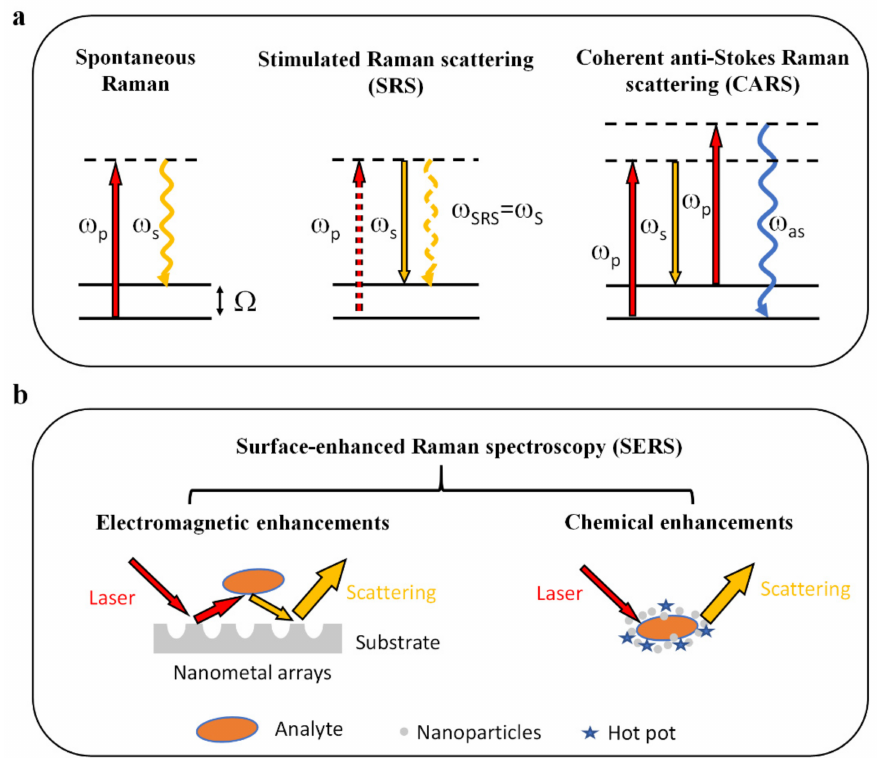
Figure 1. Physical principles of Raman-based techniques. ( a ) Energy level diagrams representing the generation of emission signals. For spontaneous Raman scattering, the molecule is excited to a virtual energy state. It then returns to a lower energy level, accompanied by light scattering, which usually relies on Stokes Raman scattering. CRS, including SRS and CARS, is a nonlinear optical process based on the interaction between pump and Stokes lasers. ( b ) Mechanisms for SERS. SERS relies on electromagnetic and chemical enhancements, increasing Raman signal intensities by up to 10 8 –10 14 orders of magnitude. Ω p , pump beam; ω s , Stokes beam; ω as , anti-Stokes beam; Ω , Raman-active molecular vibration (adapted and reproduced from reference